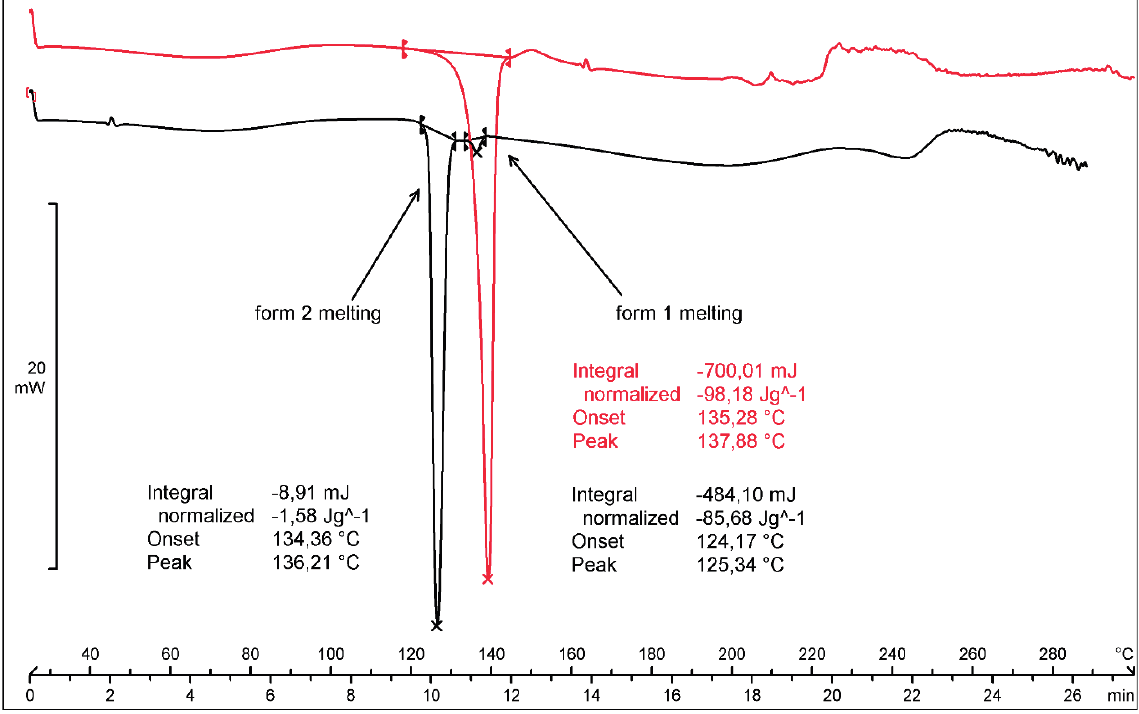
Figure 2. DSC profiles of pemetrexed diacid forms 1 and 2 .